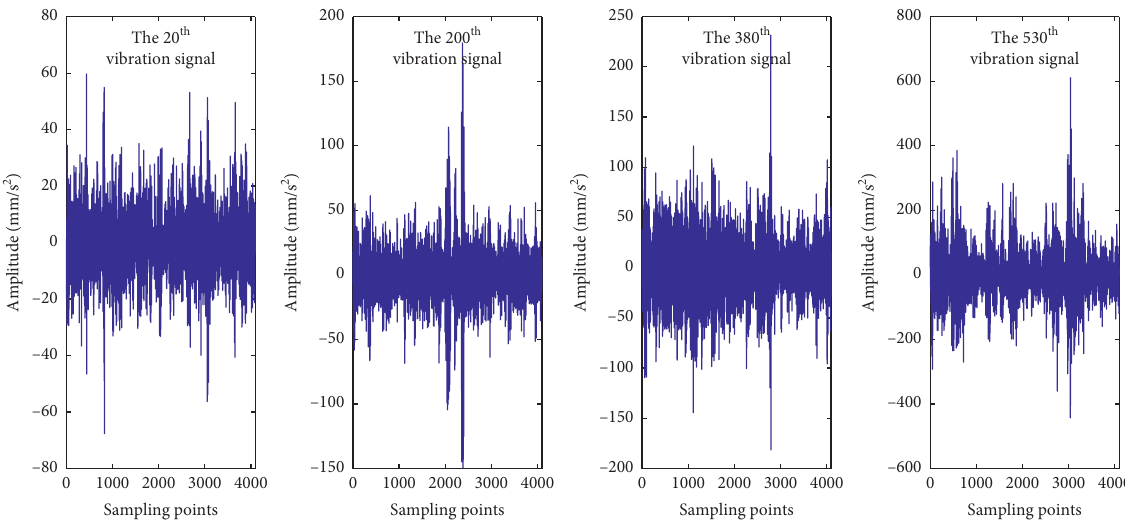
Figure 9: Vibration signals X